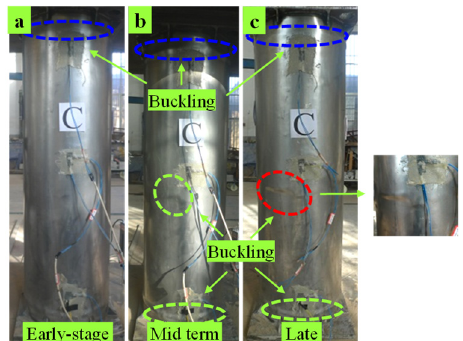
Figure 4. Damage phenomenon of C1. ( a ) Early-stage ( b ) Mid term ( c )